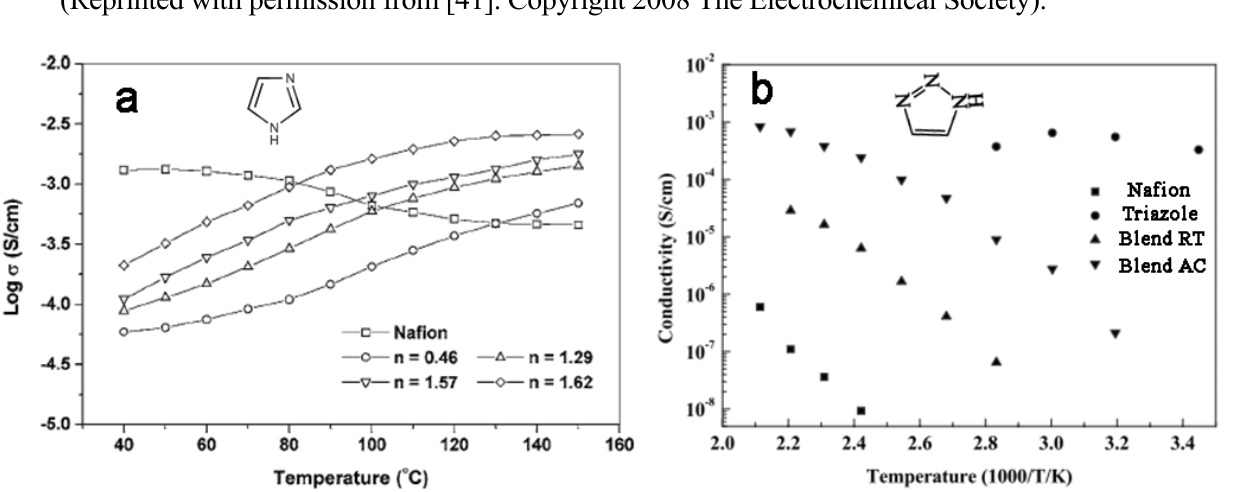
Figure 3. The proton conductivities of ( a ) Nafion-imidazole and ( b ) Nafion-triazole composite membranes as a function of temperature for high temperature